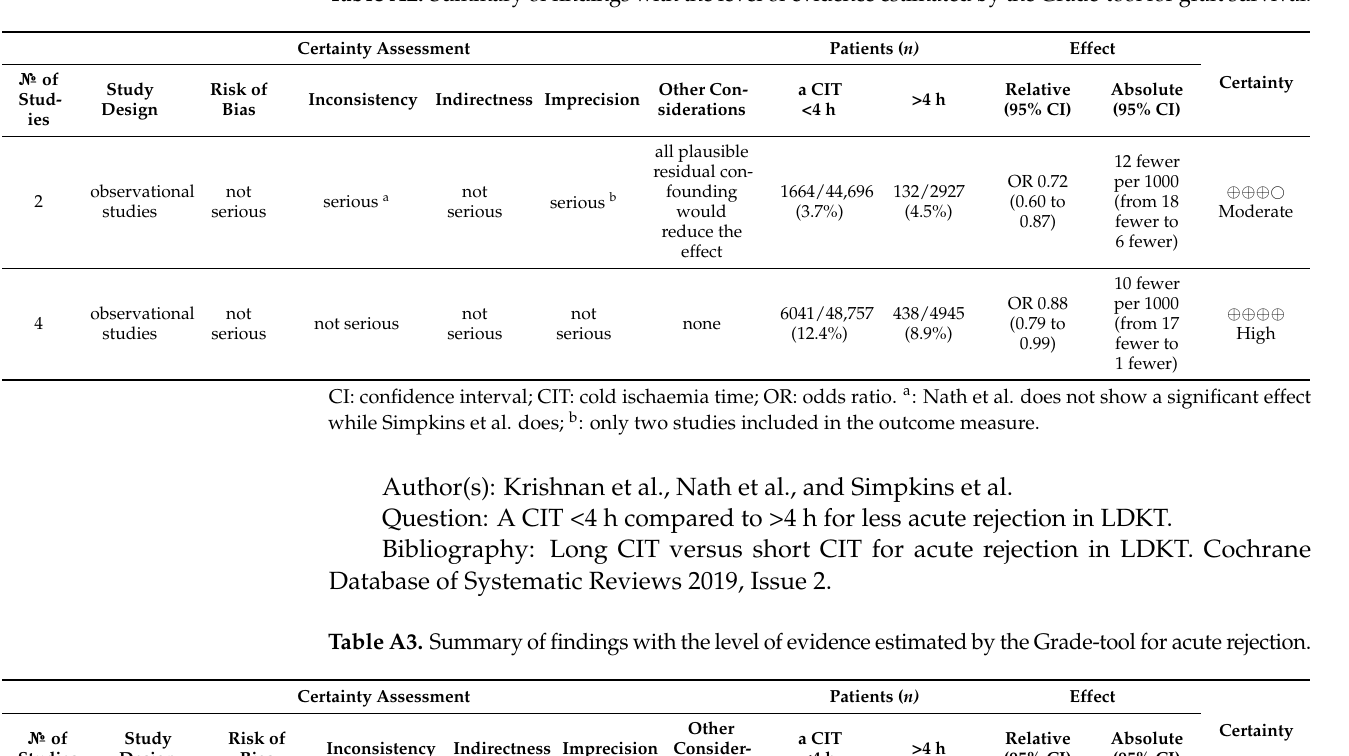
Table A2. Summary of findings with the level of evidence estimated by the Grade-tool for graft survival.